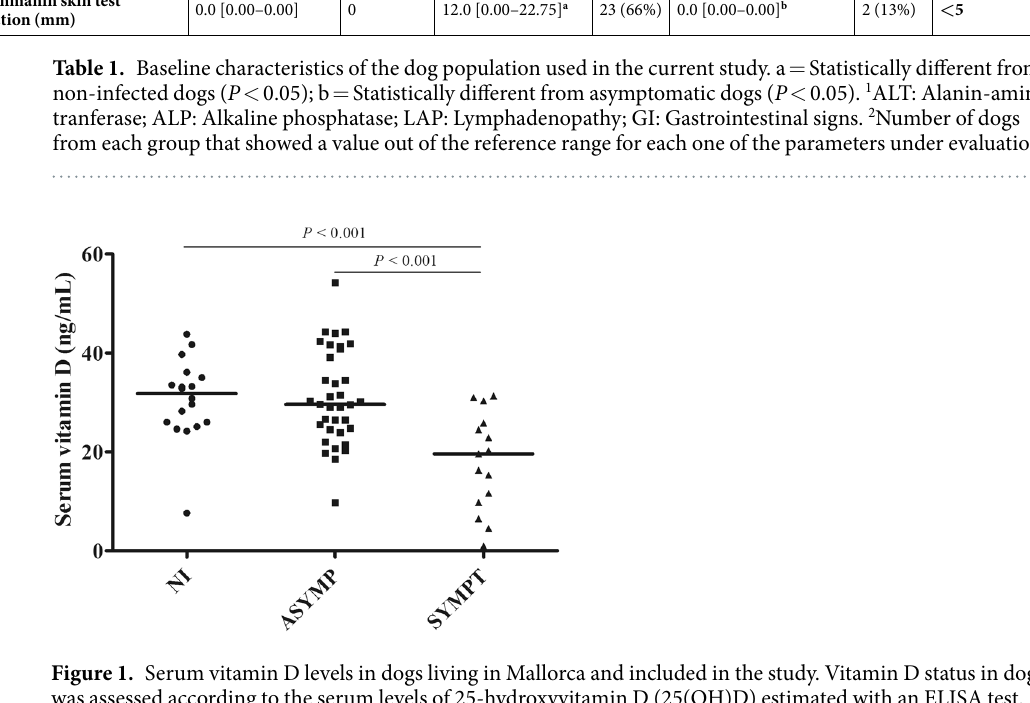
transcript ENSCAFT00000014506. The other two SNPs were located in introns 3 (g.6894812 A > G) and 7 (rs852900542). Genotyping of the 4 VDR SNPs in the cohort of 51 dogs showed intermediate allelic frequencies for SNPs g.6894812 A > G and rs851938503, and low minor allele frequencies (MAF) for SNPs rs852643282 and rs852900542 (Table 3 and Supplementary Table S2). Importantly, the allelic frequencies of the 4 SNPs were not statistically different between the three disease classes and between non-infected vs infected (symptomatic and asymptomatic) dogs, as determined with a χ 2 test of independence (Table 4).